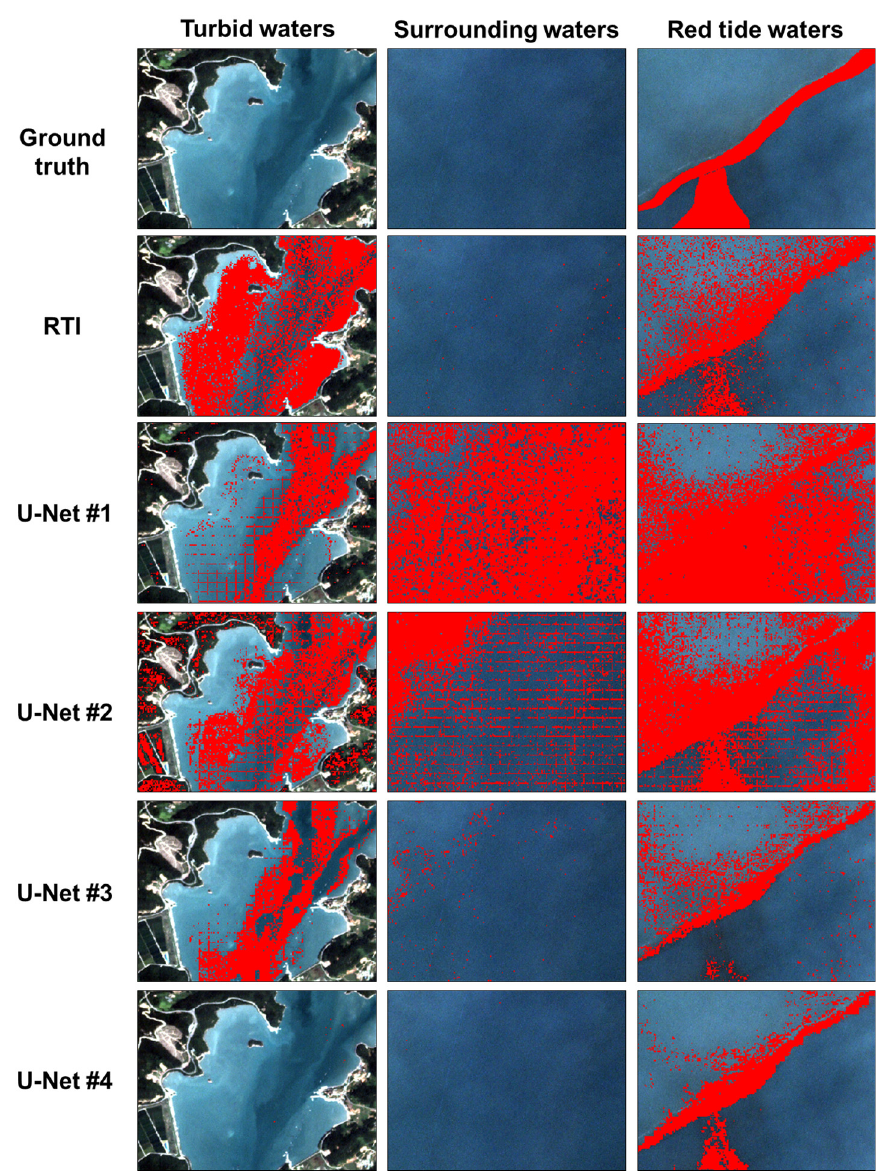
Figure 8. Ground-truth and red tide maps generated by RTI and four U-Net models in the three water types of turbid, surrounding, and red tide waters from a PlanetScope image acquired on 29 July 2018 at 01:42 GMT near the coast of Goheung. Red tide pixel was marked in red.